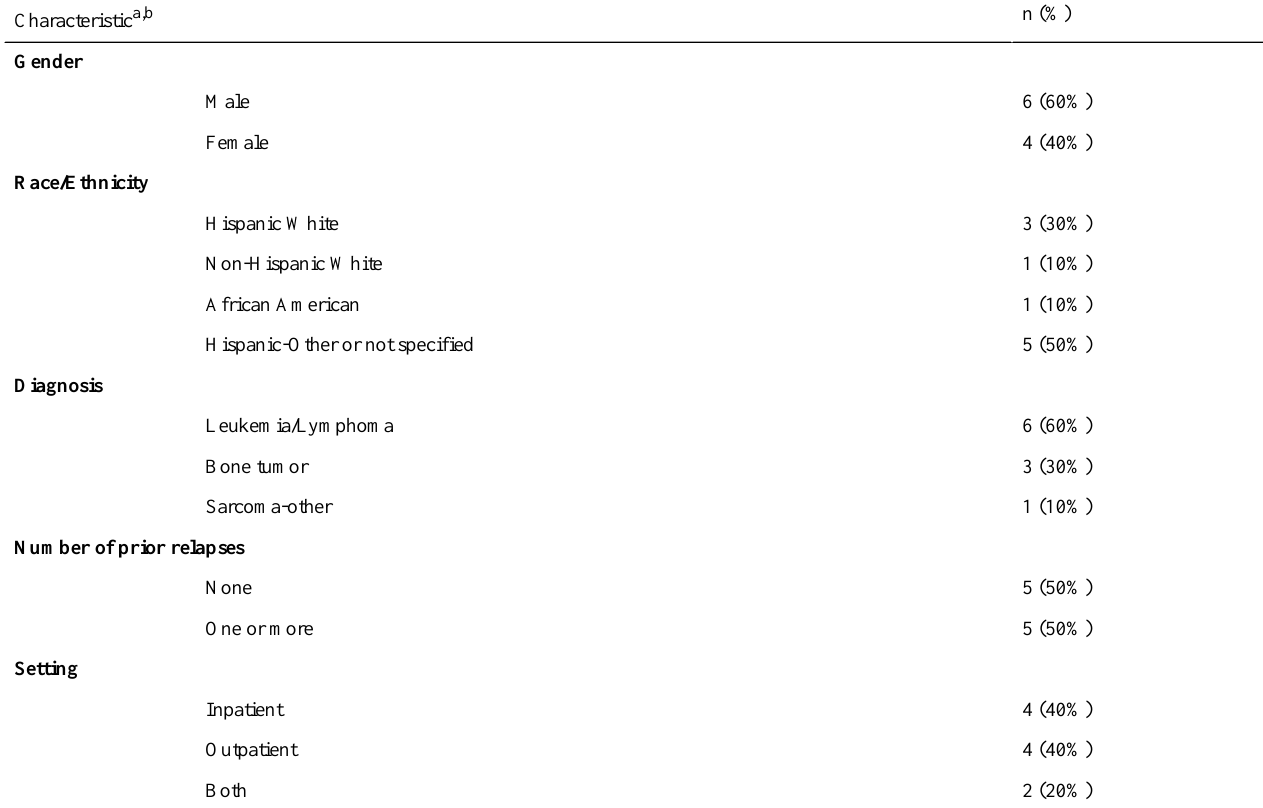
Table 1. Demographic and clinical characteristics of participants